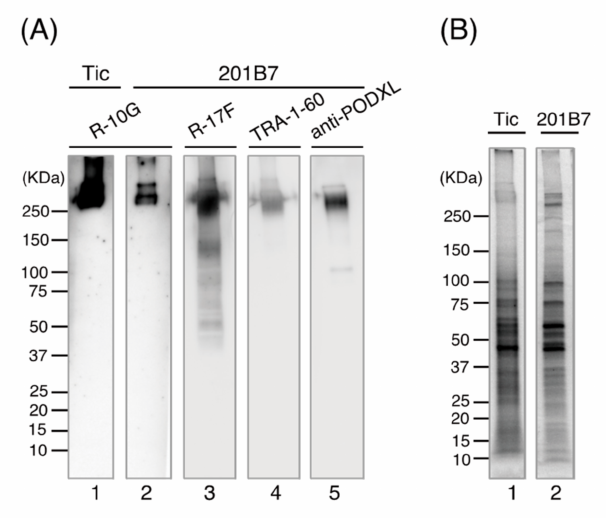
Figure 1. SDS-PAGE of iPSC lysates and Western blotting using the indicated antibodies. ( A ) Whole- cell lysates of 201B7 cells (8.0 × 10 4 ) and Tic cells (6.2 × 10 4 ) in complete RIPA buffer were resolved by SDS-PAGE on a 4–15% gradient gel under reducing conditions. The proteins were Western blotted using R-10G, R-17F, TRA-1-60, and anti-podocalyxin antibodies (3 µ g protein/mL). ( B ) Gel Code Blue-stained gel of 201B7 (7.7 × 10 4 ) and Tic (5.2 × 10 4 ) cell